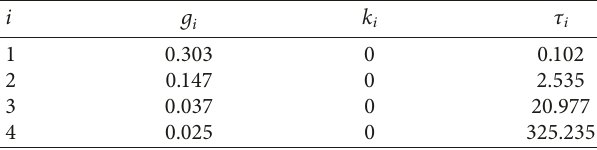
Table 2: Prony series parameters of the rubber